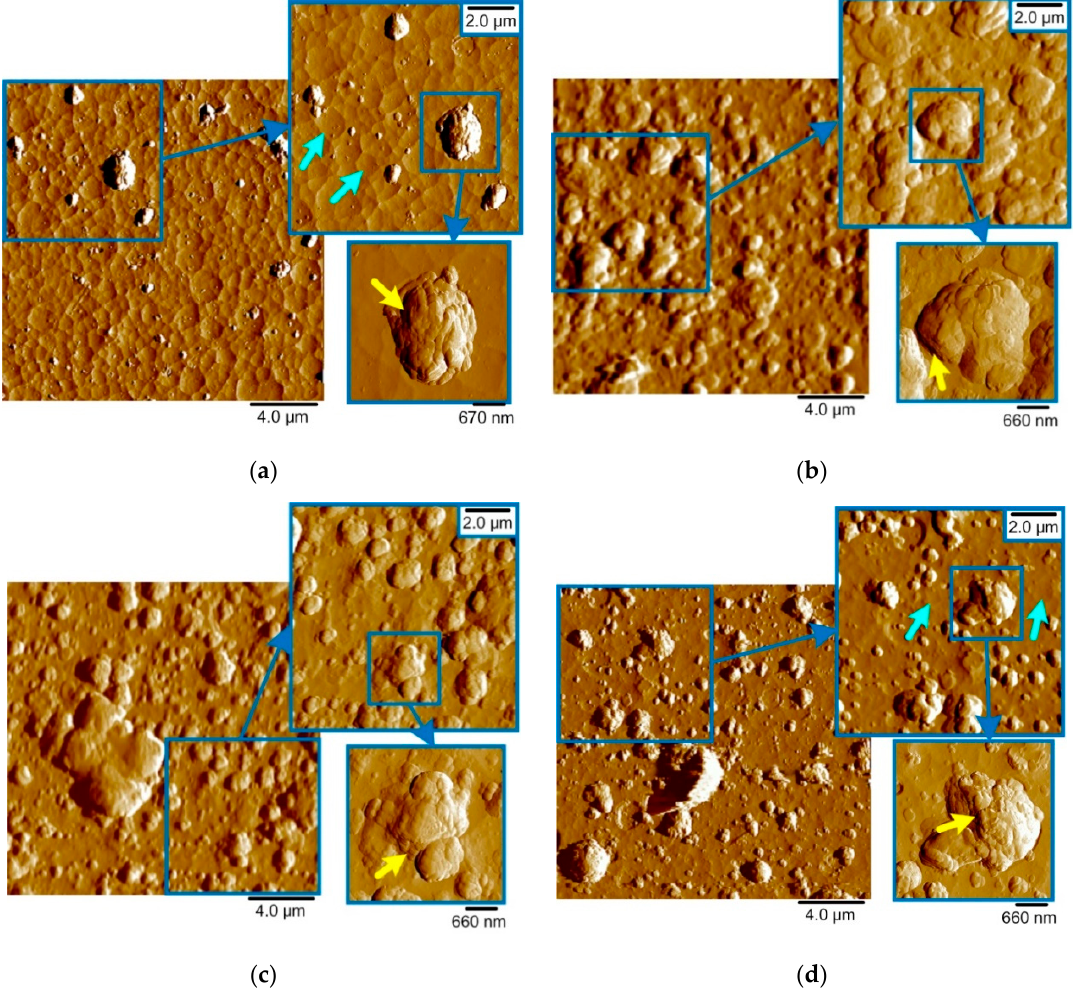
Figure 4. Two-dimensional AFM images of the AlCrN coatings, area 20 × 20 µm 2 : ( a ) CrN; ( b ) Figure4. Two-dimensionalAFMimagesoftheAlCrNcoatings, area20 × 20 µ m 2 : ( a )CrN;( b )Al 50 Cr 50 N; Al 50 Cr 50 N; ( c ) Al 70 Cr 30 N; ( d ) Al 80 Cr 20 N. ( c ) Al 70 Cr 30 N; ( d ) Al 80 Cr 20